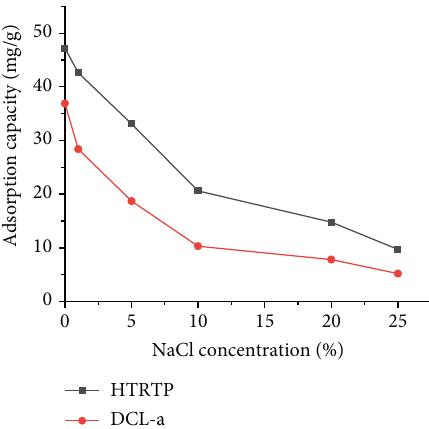
Figure 7: E ff ect of NaCl content on adsorption quantity of DCL-a and HTRTP.